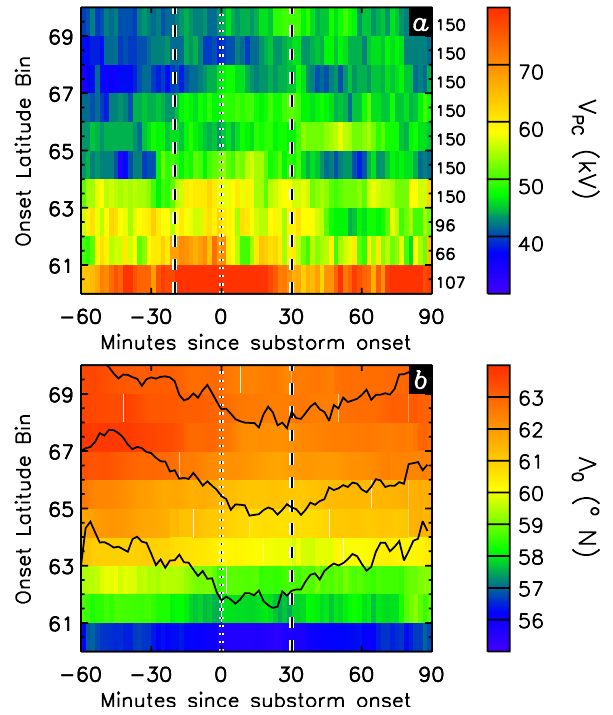
Fig. 4. (a) The ionospheric transpolar voltage, V PC and (b) the magnetic latitude of the zero-potential boundary of the convection pattern, 3 0 , derived from the results of the Map Potential analysis and plotted as a function of time relative to substorm onset for the ten onset-latitude bins. In each case the parameter’s magnitude is indicated by the corresponding colour bar. The vertical dotted lines indicate the time of substorm onset in the superposed-epoch and the dashed lines highlight times which are referred to in the text. On the right-hand side of panel (a) the number of substorms that contributed to the global convection analysis for each onset-latitude bin is